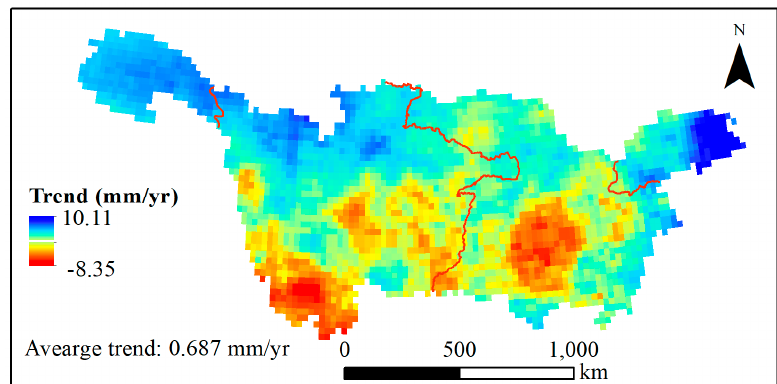
Figure 13. The spatial pattern of the trend of annual precipitation from 1984 to 2018 in the YRB. The magnitude of trends was evaluated by a linear regression model.